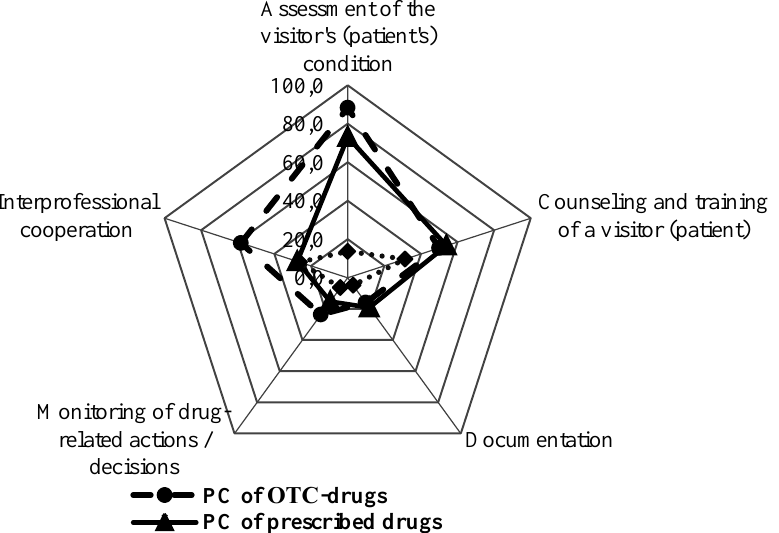
Fig. 4. Assessment of the success of implementation in pharmacy establishments of Ukraine of five factors of